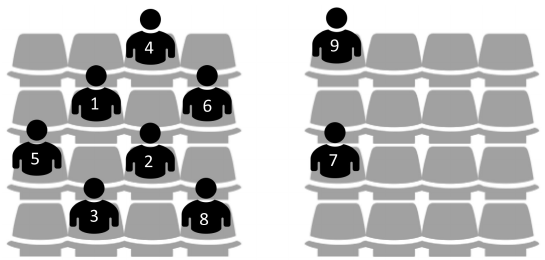
Figure 12. Location distribution of each WBASN in the performance-evaluation-with-entry model.